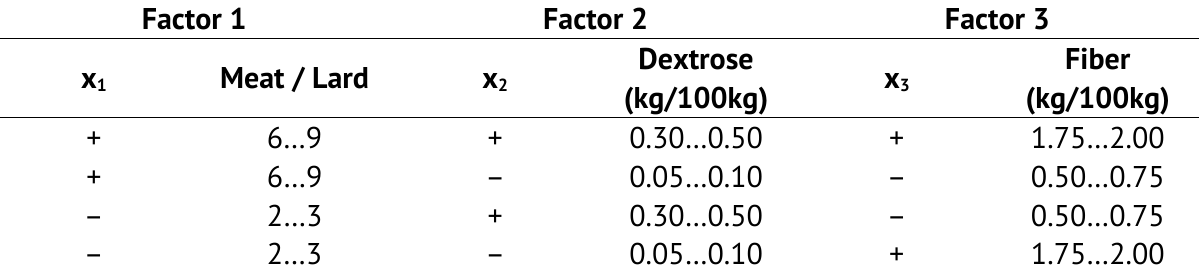
Experiment-planning matrix in the encoded and real